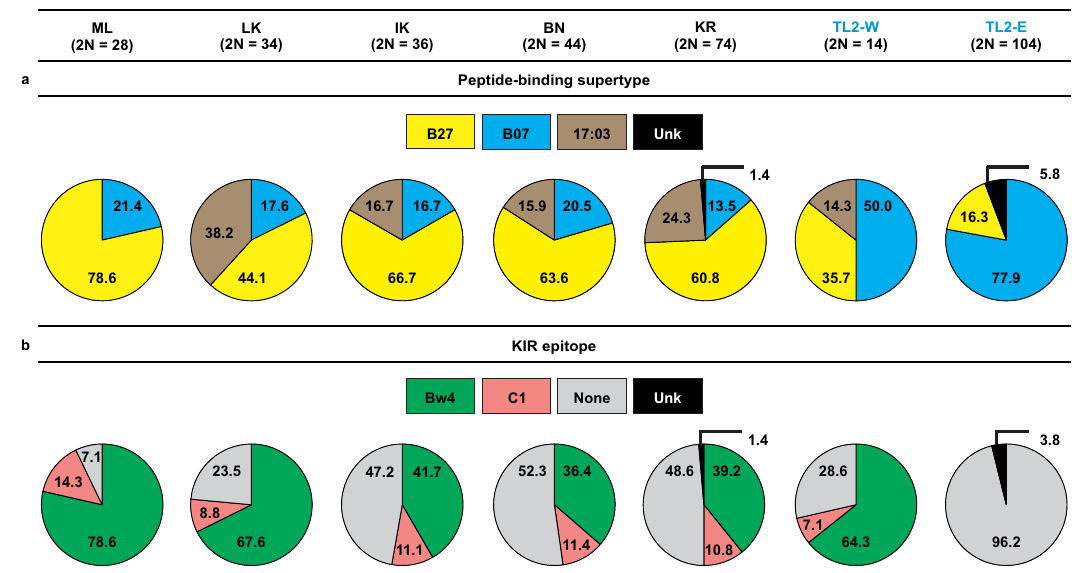
Fig. 3 | FrequenciesofPapa-B allelesin bonobopopulations. For each fi eld site, thenumberofPapa-Ballotypesisshown.Unknown(Unk)second Papa-Ballotypes in TL2-E and KR are indicated in black (Fig. 2). Sites with endemic Laverania infection are shown in blue font. Source data are provided as a Source Data fi le. a Frequencies of the three Papa-B peptide-binding supertypes are shown: B27 (yellow),B07(blue),Patr-B*17:03(17:03,brown).B07ismorefrequentinTL2-Eand TL2-W than in any western population (two-tailed Fisher ’ s exact tests with